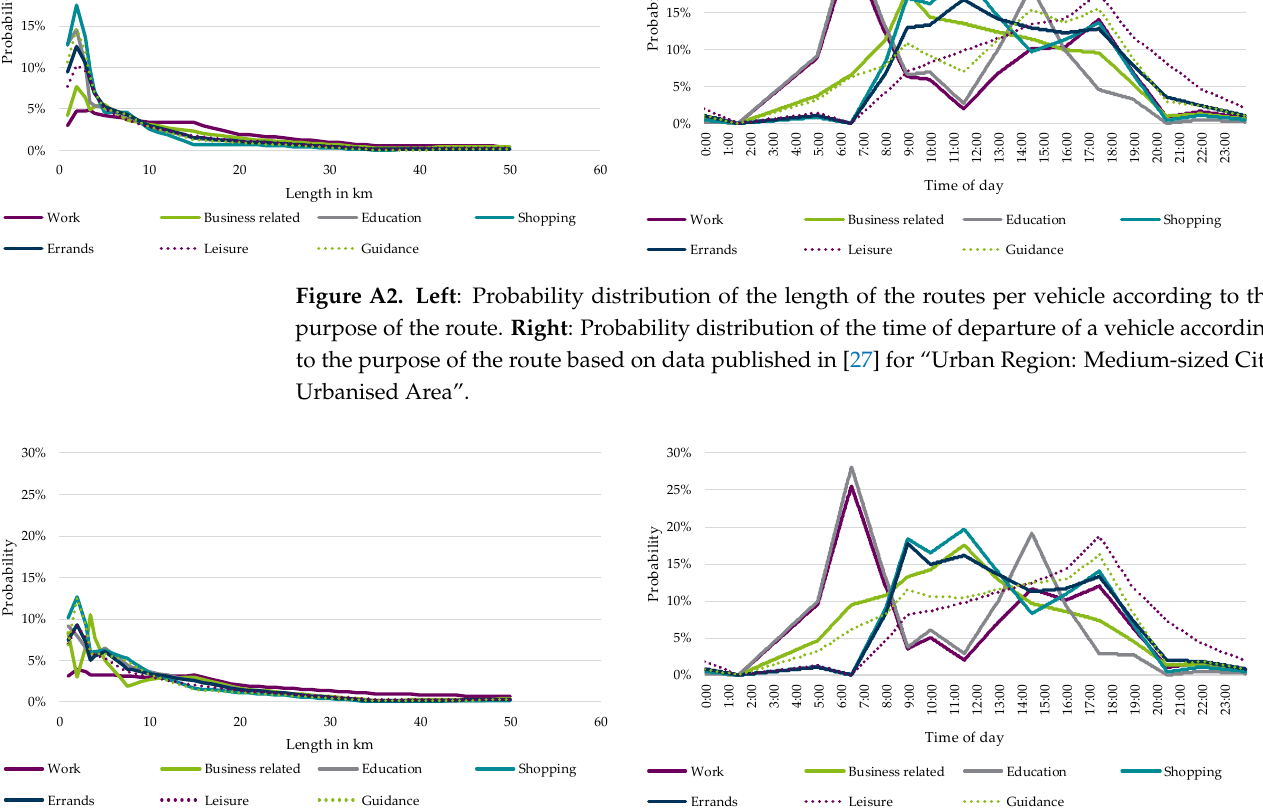
Figure A3. Left : Probability distribution of the length of the routes per vehicle according to the pur- pose of the route. Right : Probability distribution of the time of departure of a vehicle according to the purpose of the route based on data published in [27] for “Urban Region: Small-town Area, Vil- lage Area”.